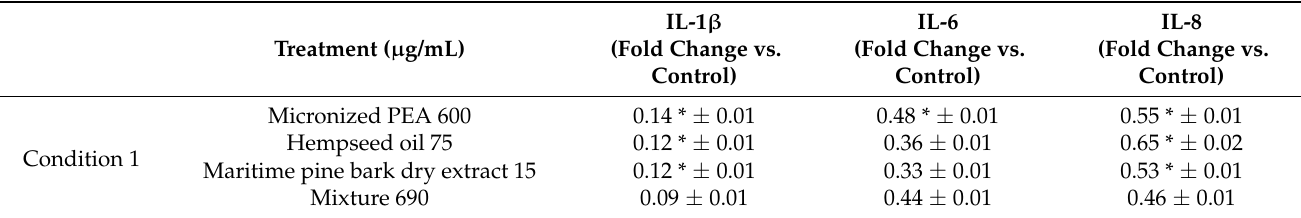
Figure 4. Expression of ( a ) IL-1 β , ( b ) IL-6, and ( c ) IL-8, reported as fold changes compared to control (cells treated with medium conditioned only with the inflammatory stimulus, E. coli ) after treatment of bladder urothelium cells with the three functional ingredients and their mixture at different concentrations. Table 3. Expression of IL-1β, IL-6, and IL-8, reported as fold changes compared to control (cells treated with medium conditioned only with the inflammatory stimulus, E. coli ) after treatment of bladder urothelium cells with the three functional ingredients and their mixture at different concentrations. * indicates statistical significance set at p < 0.05 for the comparison between mix and each ingredient singularly taken. (Fold Change vs. Control)